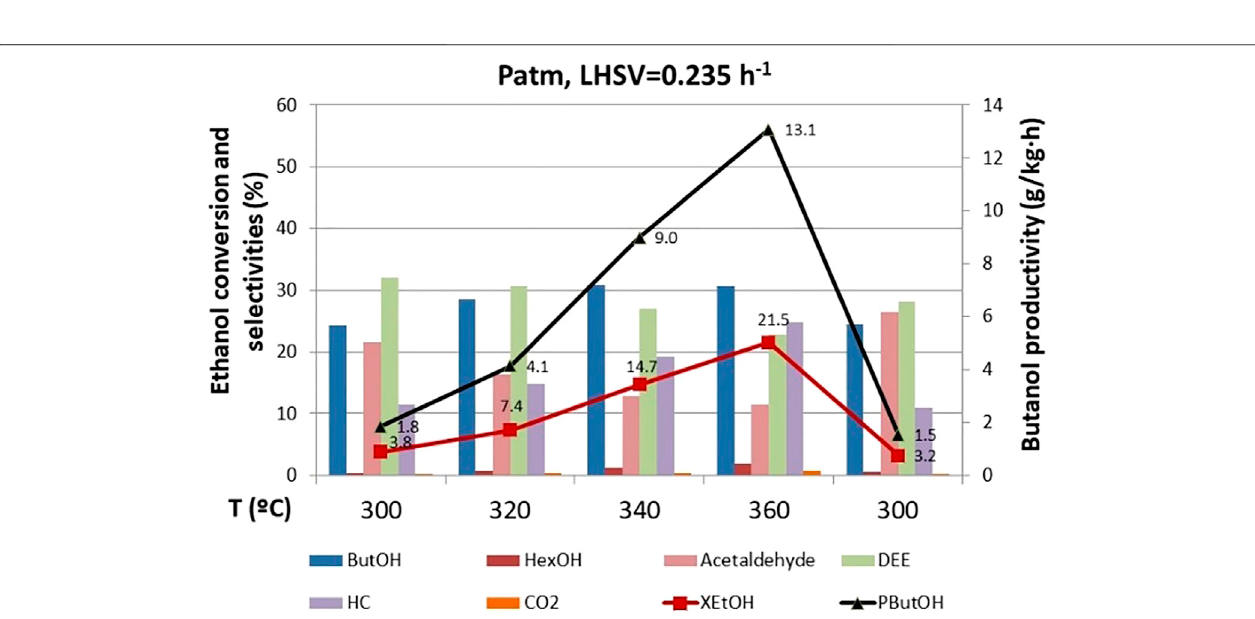
FIGURE 5 | Effect of temperature on ethanol conversion, butanol productivity, and selectivity to products. ButOH = butanol; HexOH = hexanol; HC = hydrocarbons; DEE = diethyl ether.